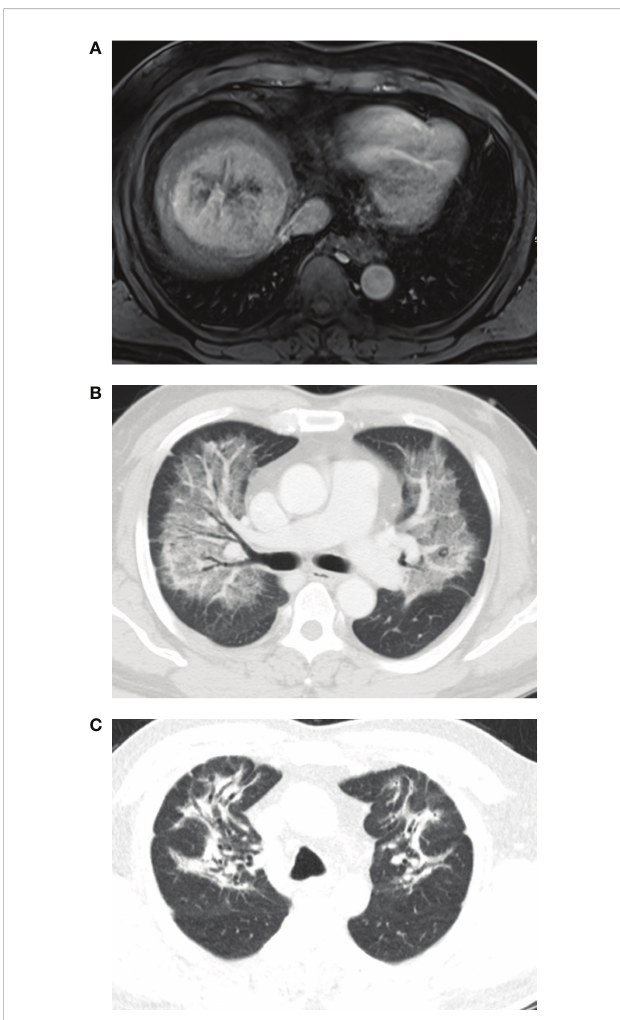
FIGURE 1 A 65-year-old man had a 9cm single mass in the right lobe. The lung shunt fraction was 14.1%, and 2.4 GBq of resin 90 Y-microspheres were delivered into the right hepatic artery. The estimated lung dose was 21.01 Gy. (A) Magnetic resonance shows a mass in right lobe. (B) Chest CT scan 3.8 months after radioembolization shows diffuse consolidation and ground-glass opacity in both the lungs with subpleural sparing. (C) Chest CT scan 4 months after steroid therapy shows fi brotic changes in both the lungs.